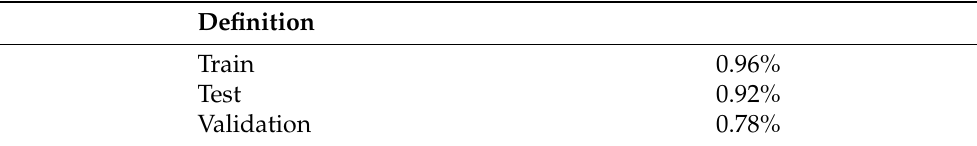
Table 5. Model validation based on extreme gradient boosting.